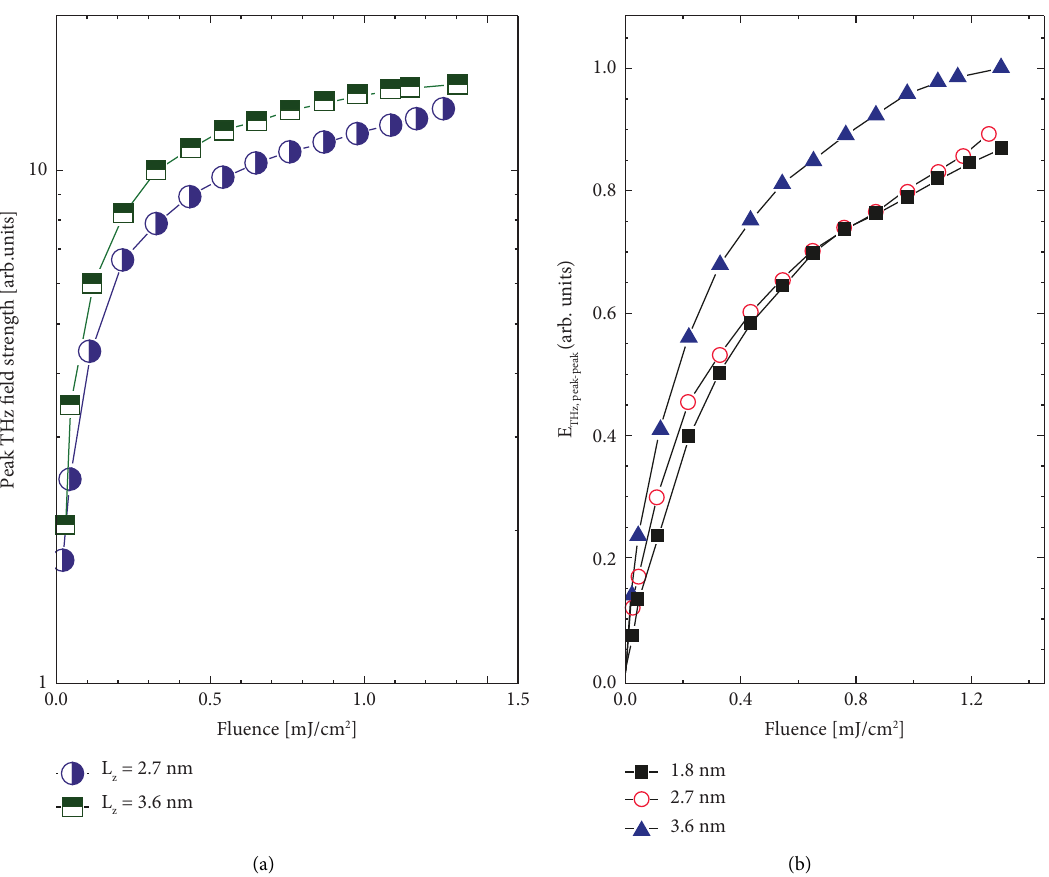
Figure 5: (a) Peak-peak feld strengths of THz pulses for varying excitation fuences. (b) THz peak-peak amplitudes versus fuence for various QW thicknesses. Reproduced with permission from the American Physical Society. Copyright American Physical